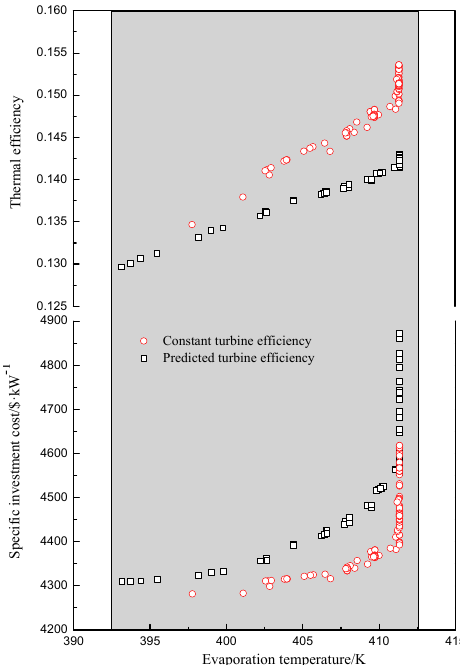
Figure 9. Distribution of optimal evaporation temperature.